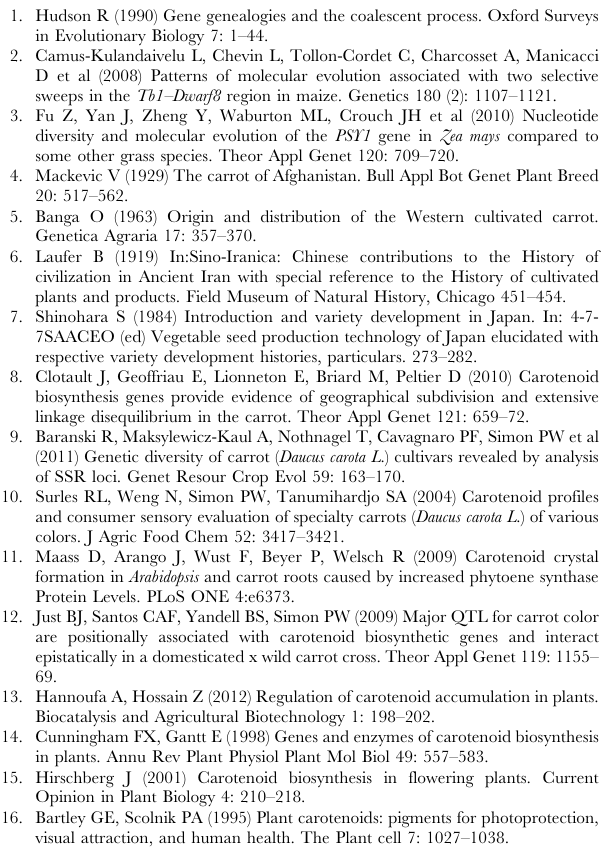
displayed for the whole dataset (black line), Western group (blue line), Eastern group (green line), white group (grey line), yellow group (yellow line), orange group (orange line), red group (red line) and purple group (purple line). The significance is shown as P -